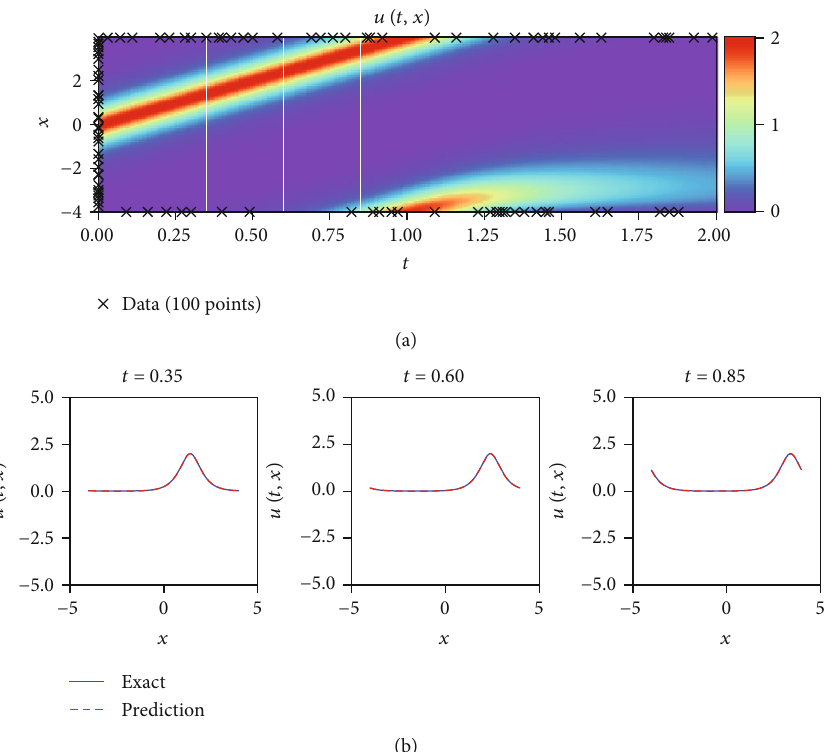
Figure 9: mkdv equation. (a) Predicted solution u ð t , x Þ . (b) Predicted solution and exact solution at t = 0 : 35, 0 : 60, 0 : 85 were depicted by the white vertical lines in (a). The red dashed line is predicted solution, and the blue line is exact solution of u ð x , t Þ